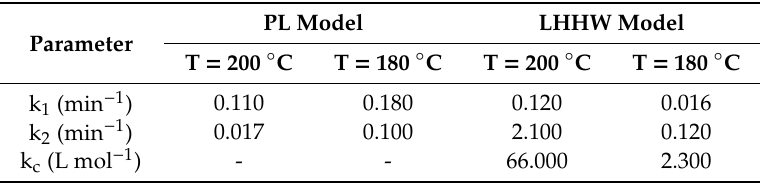
Figure 8. Fittings through the Langmuir–Hinshelwood–Hougen–Watson (LHHW) model concerning HMF adsorption. ( A ) Cellulose concentration experimental and modeling (g / L); ( B ) HMF production experimental and modeling (g / L).